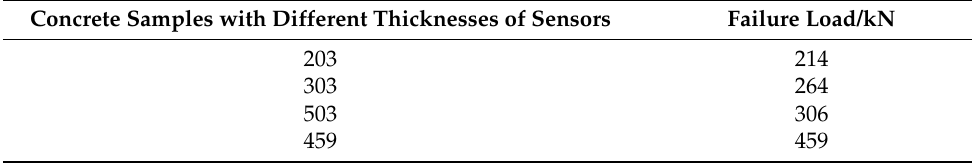
Table 3. Maximum failure load of concrete specimens with different thicknesses of sensors.